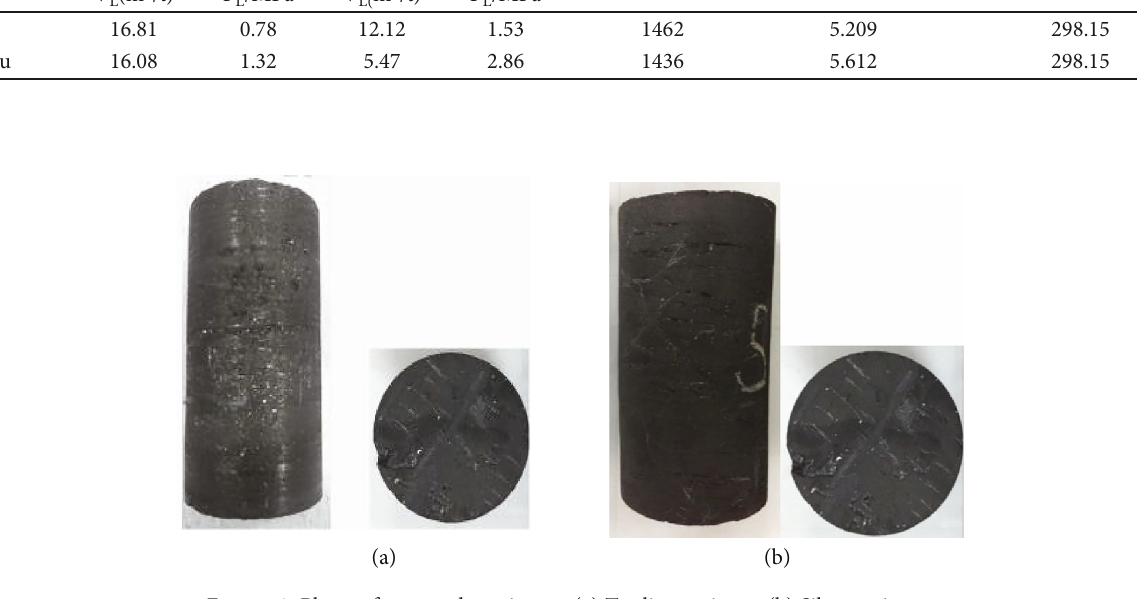
Figure 2: Photo of prepared specimens. (a) Tunliu specimen. (b) Sihe specimen.